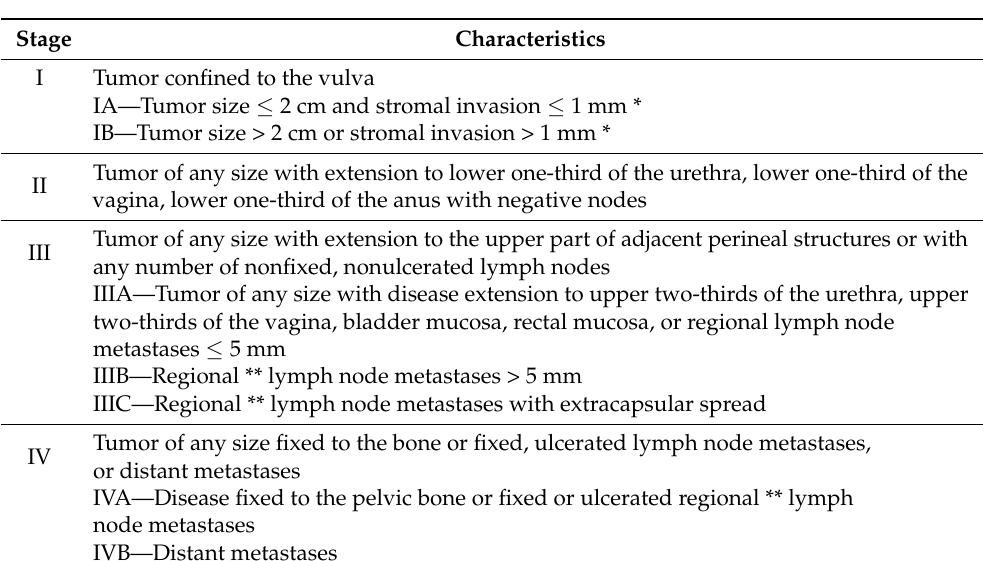
Table 3. Revised 2021 FIGO staging of vulvar